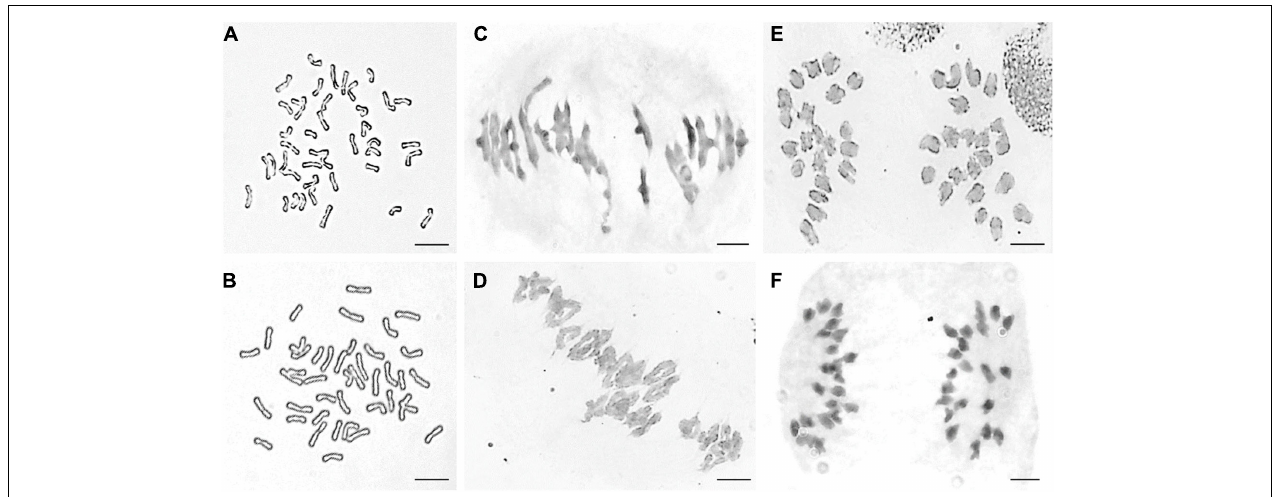
FIGURE 1 | Cytological observation of root tip cells (RTCs) and pollen mother cells (PMCs). (A) Mitotic metaphase of DH109, 2 n = 42. (B) Mitotic metaphase of DM131, 2 n = 42. (C) Meiotic metaphase I of DH109, 2 n = 21 II. (D) Meiotic metaphase I of DM131, 2 n = 21 II. (E) Meiotic anaphase I of DH109, 2 n = 21 + 21.